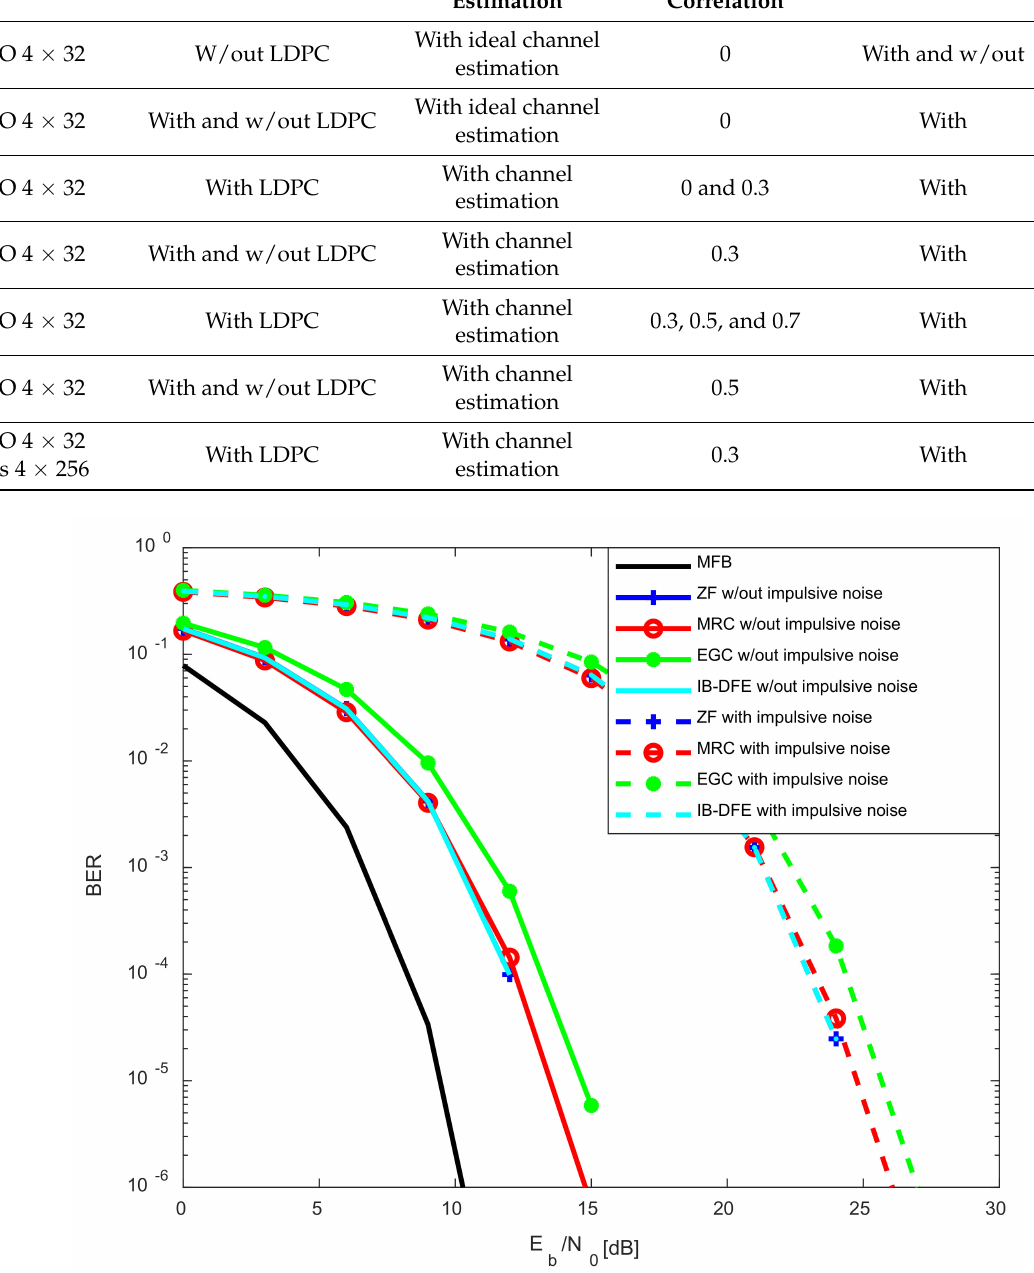
Figure 3. Results for 4 × 32 MIMO (with and without impulsive noise), without LDPC codes, with ideal channel estimation and without channel correlation between